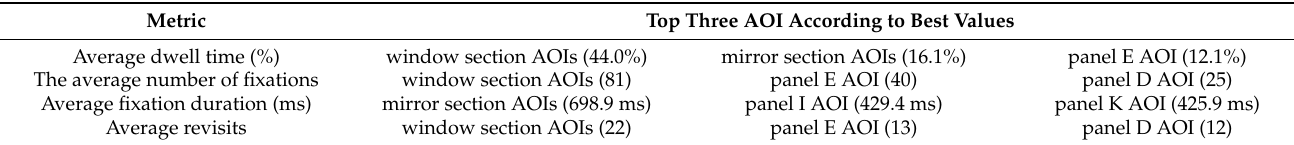
Table 5. The departure procedure’s average statistic for train station Doln ý Hriˇcov.